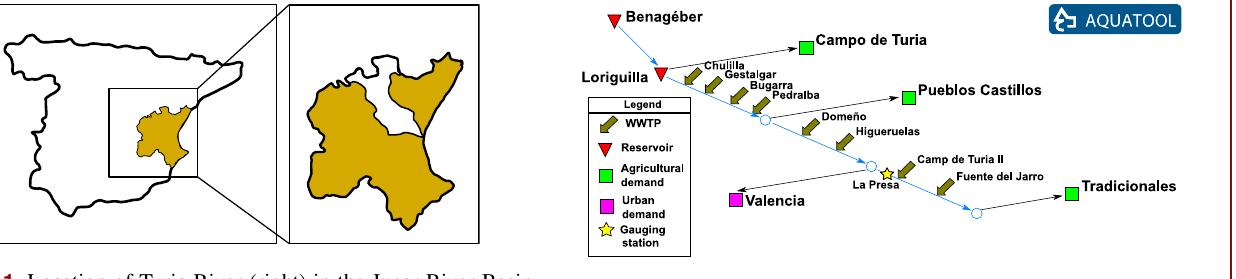
Figure 2. Scheme of the simulation model. The fundamental ele- ments characterizing the Jucar River